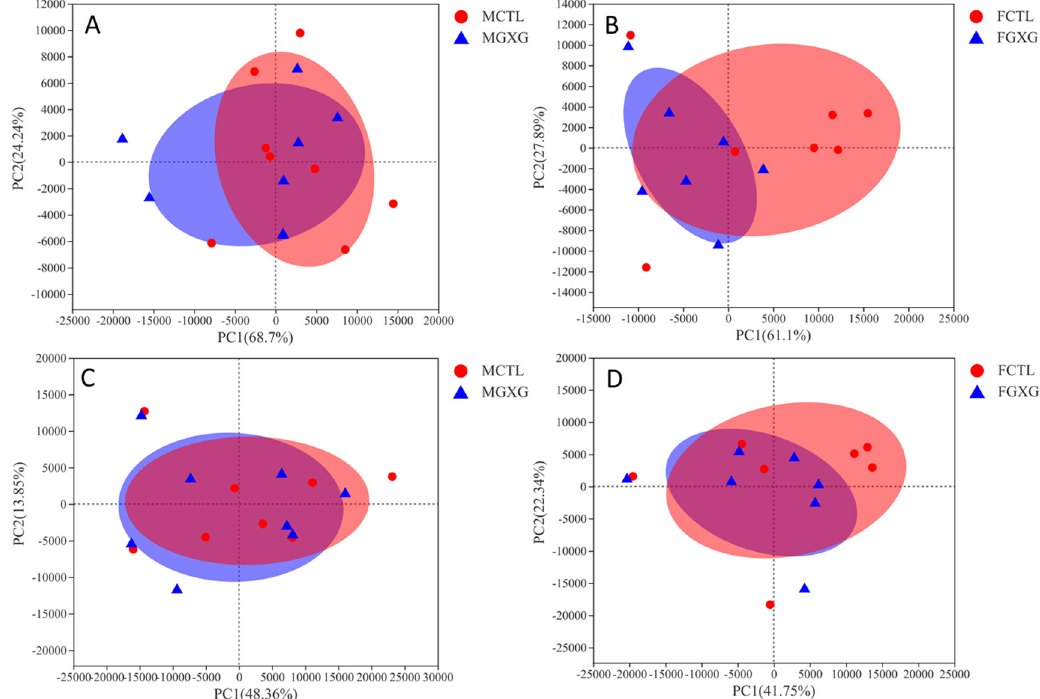
Figure 2. PCA analysis of the effect of Dendrobium officinale polysaccharides on microbiota compo- sition. ( A ) men’s phylum level; ( B ) women’s phylum level; ( C ) men’s genus level; ( D ) women’s genus level.